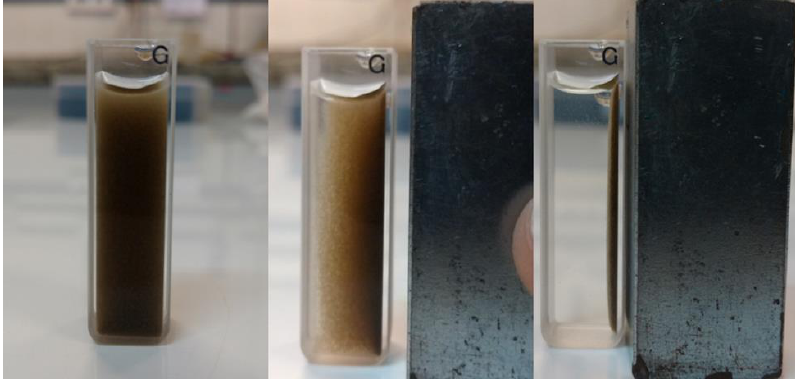
Figure 17. Separation of the magnetic CLEAs of amyloglucosidase by the action of an external magnetic field.